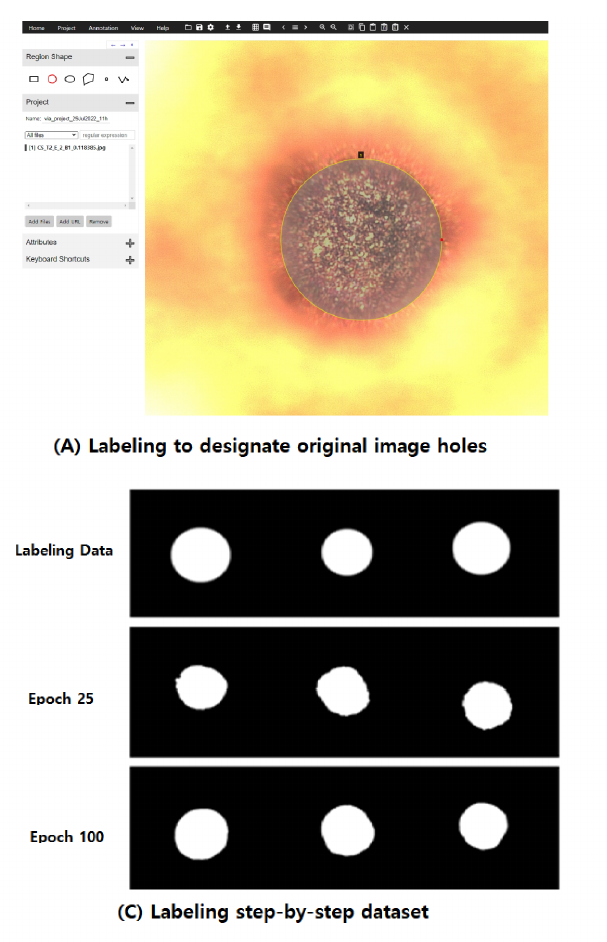
Figure 17. The U-Net training